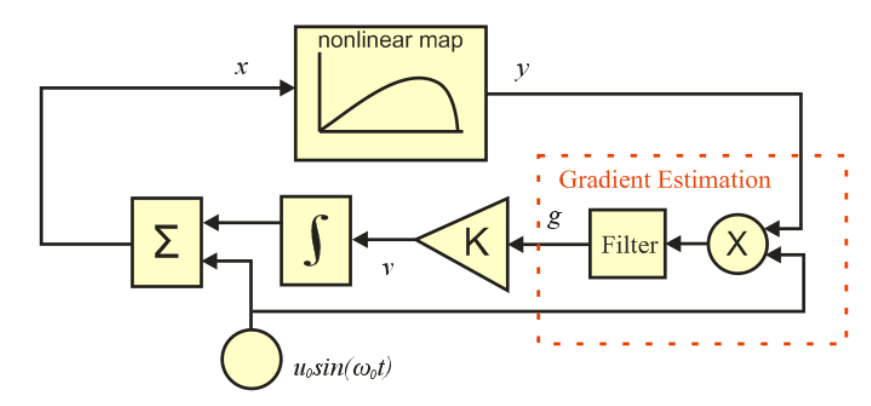
Figure 1. ESC schema.